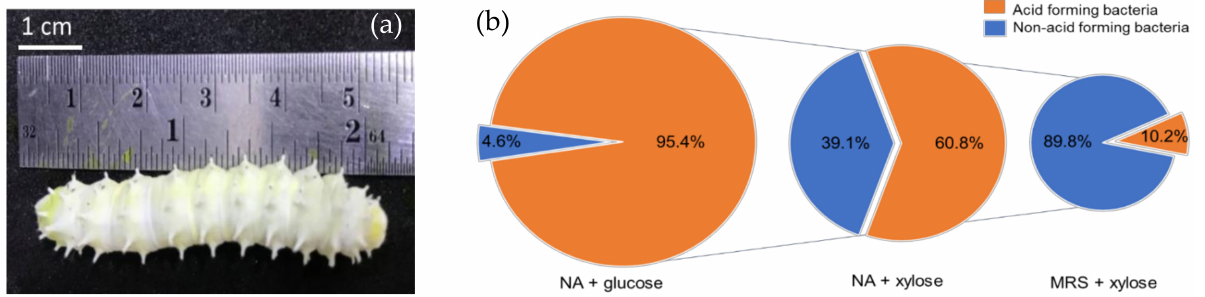
Figure 1. The mature Eri silkworm larvae cultivated at local farm in Chiang Mai, Thailand ( a ) and the pie diagram presenting the percentage of acid-forming bacteria from Eri silkworm midgut found in different agar medium ( b